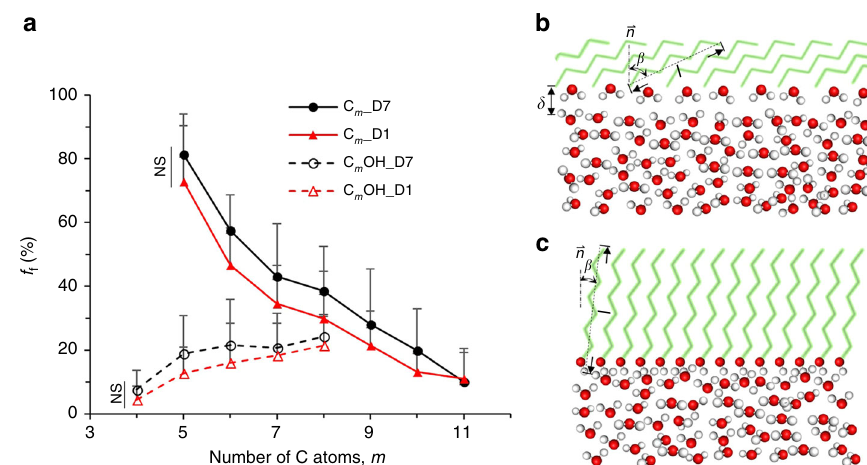
Fig. 3 Deep-supercooled water sealed with linear alkanes and primary alcohols. a f f of 1 ml deep-supercooled (DSC) water at − 20 °C. n = 7, N = 87. Error bars represent standard deviations. When m > 11 for linear alkanes and m > 8 for primary alcohols, the sealing agents are frozen at − 20 °C and cause DSC water frozen. When m < 5, the linear alkanes are gaseous under atmospheric condition and not suitable for sealing. When m < 4, the primary alcohols are miscible with water and not suitable for sealing either. b , c Schematic con fi gurations of alkane/water ( b ) and alcohol/water interface ( c ), respectively. The alkane and alcohol molecules are displayed without aliphatic hydrogen atoms and colored in light green. The O and H atoms in hydroxyl group of alcohol and water are shown in red and white dots,